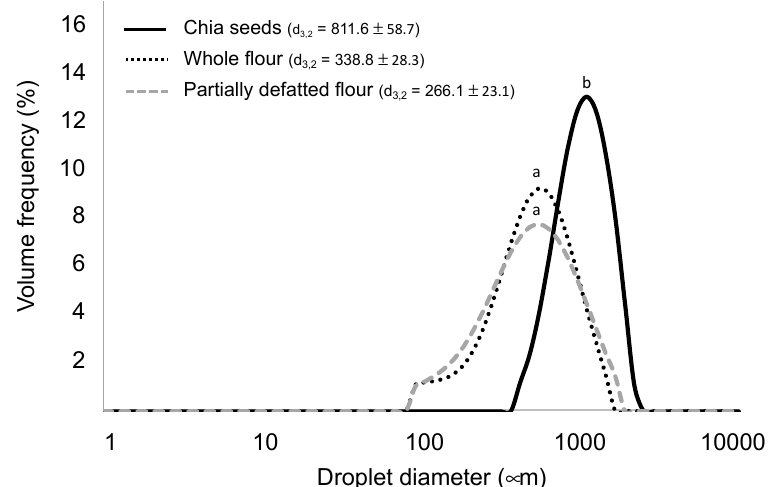
Figure 1. Particle size distributions of the chia seeds and chia flours imparted by the mechanical process and the simulated mastication. d 3,2 values sharing a same letter are not significantly different ( p < 0.05) (data are expressed as mean values from three repetitions).